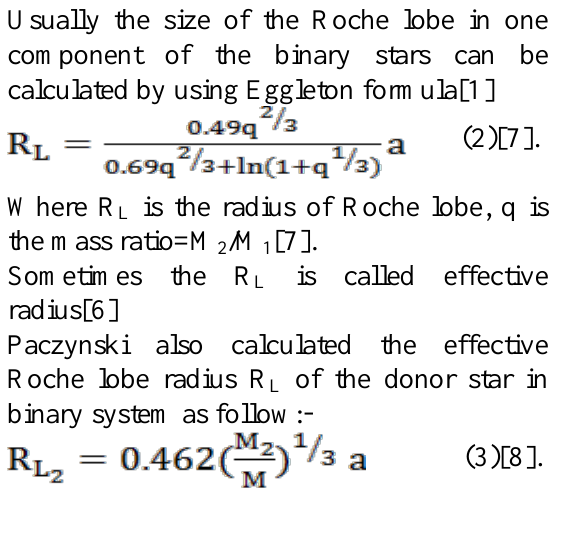
surface of the binary star system